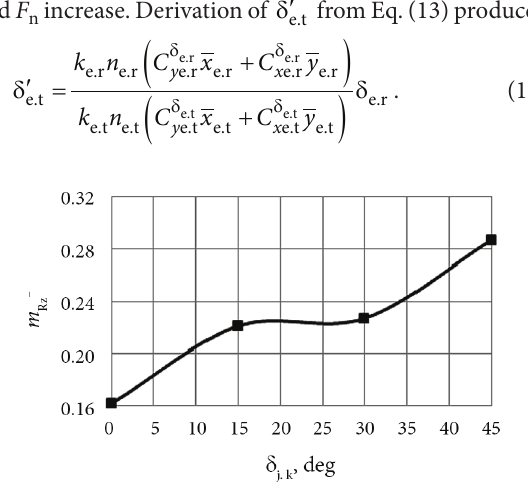
Figure 8. Change of